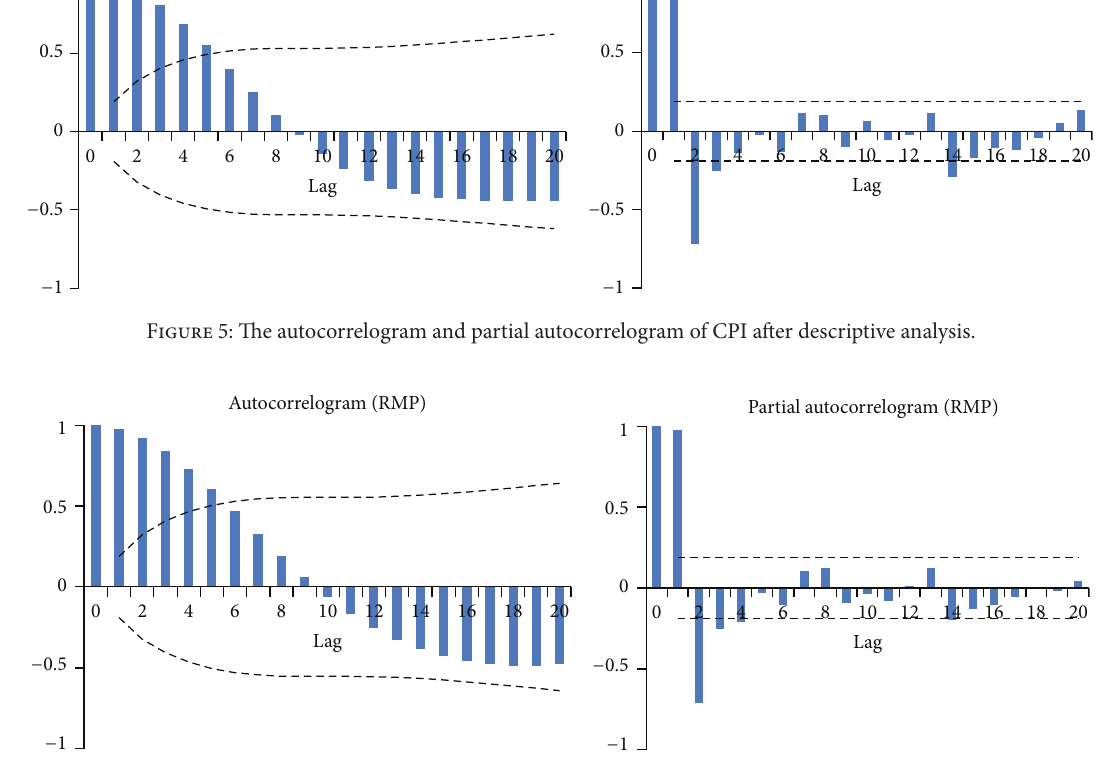
Figure 6: The autocorrelogram and partial autocorrelogram of RMP after descriptive analysis.